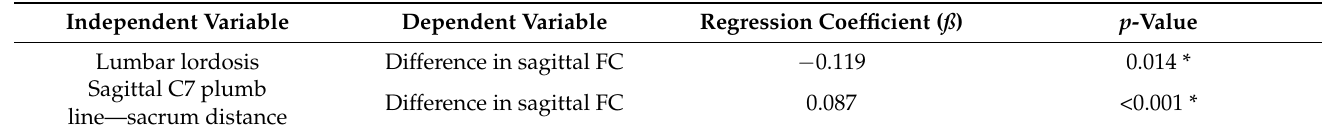
Table 6. Subgroup analysis using linear regression